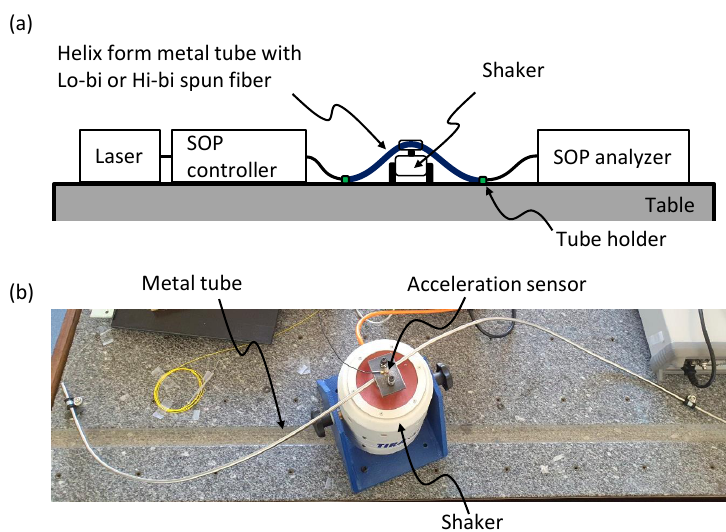
Figure 3. ( a ) Vibration experiment set-up. ( b ) A photo of the experiment’s